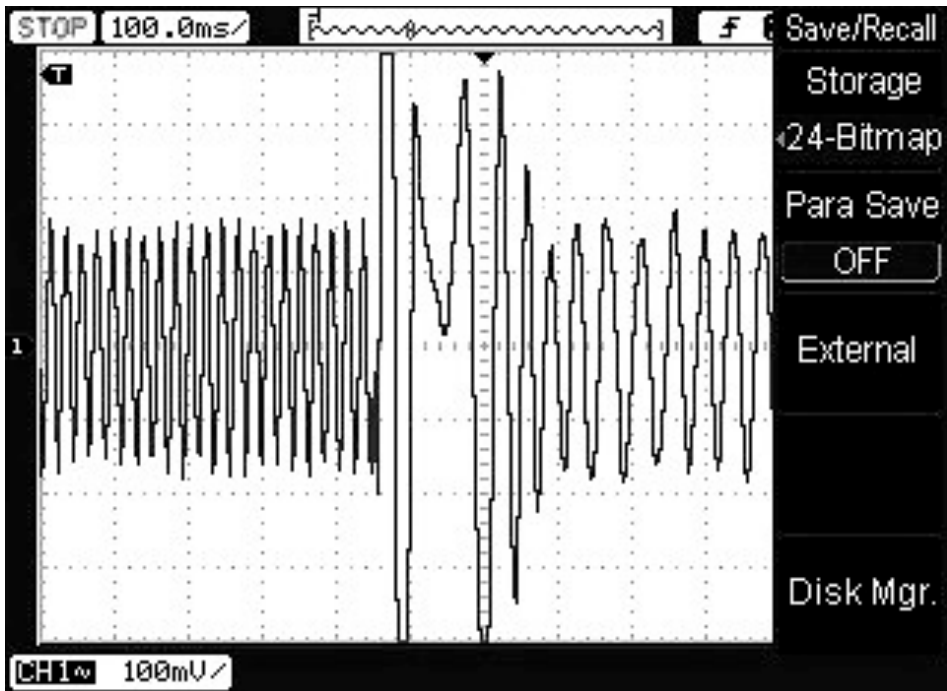
Figure 18. Current of phase ( a ) for the case of speed reversing from 0.4 pu to 0.2 pu.